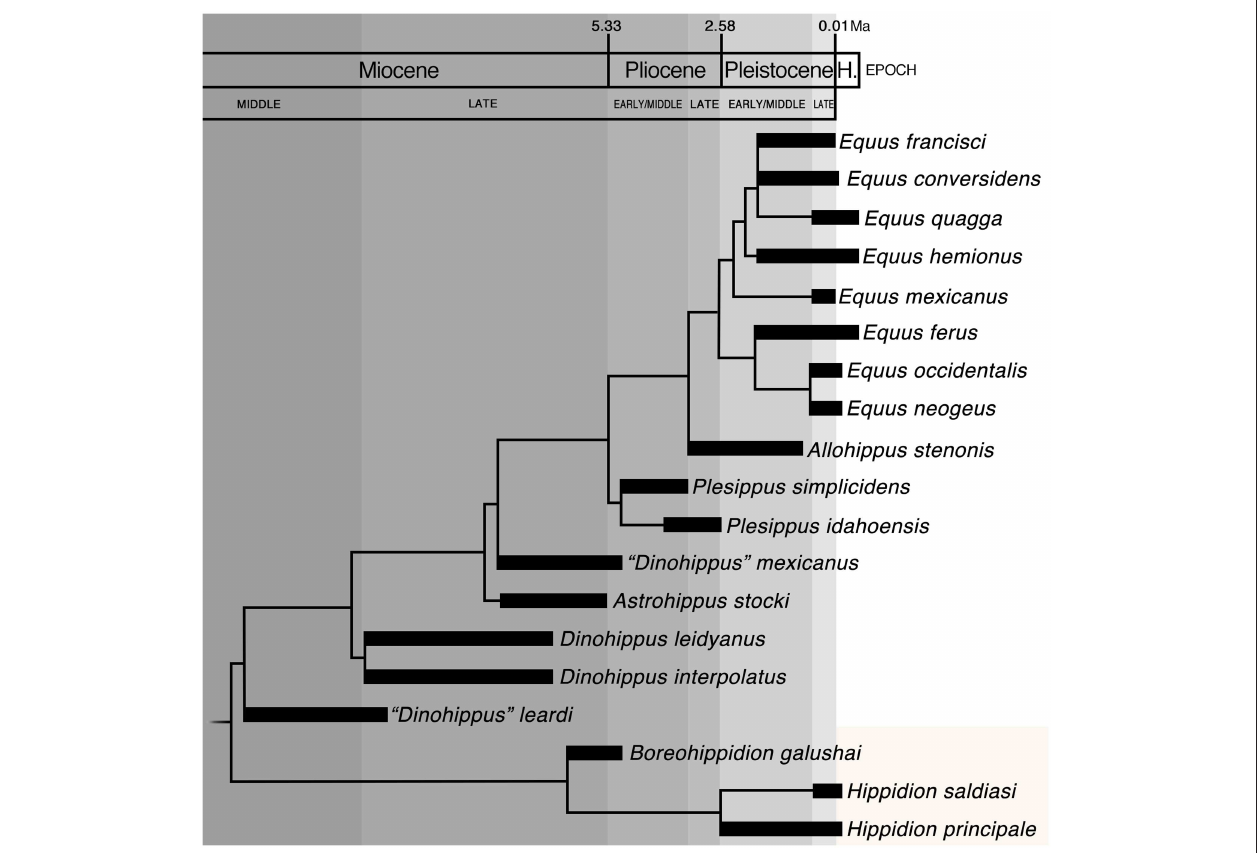
FIGURE 3 | Time-calibrated phylogeny of Equini based on fossil occurrences and the most parsimonious cladogram of 85 steps, consistency index (CI) of 0.57 and retention index (RI) of 0.80 using a matrix of 32 morphological characters and 21 Equini taxa ( Table 1 ). Outgroups ( Acritohippus stylodontus and Pliohippus pernix ) are not shown in the figure. H.,